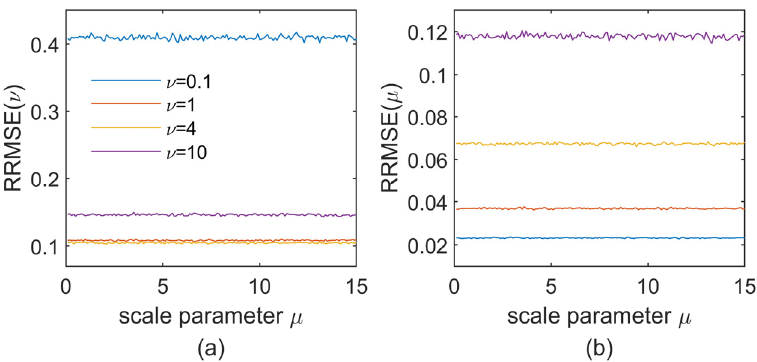
Figure 1. Influence research of the scale parameter on the RRMSEs of the TML estimation method: ( a ) RRMSEs of the inverse shape parameter, ( b ) RRMSEs of the scale parameter.